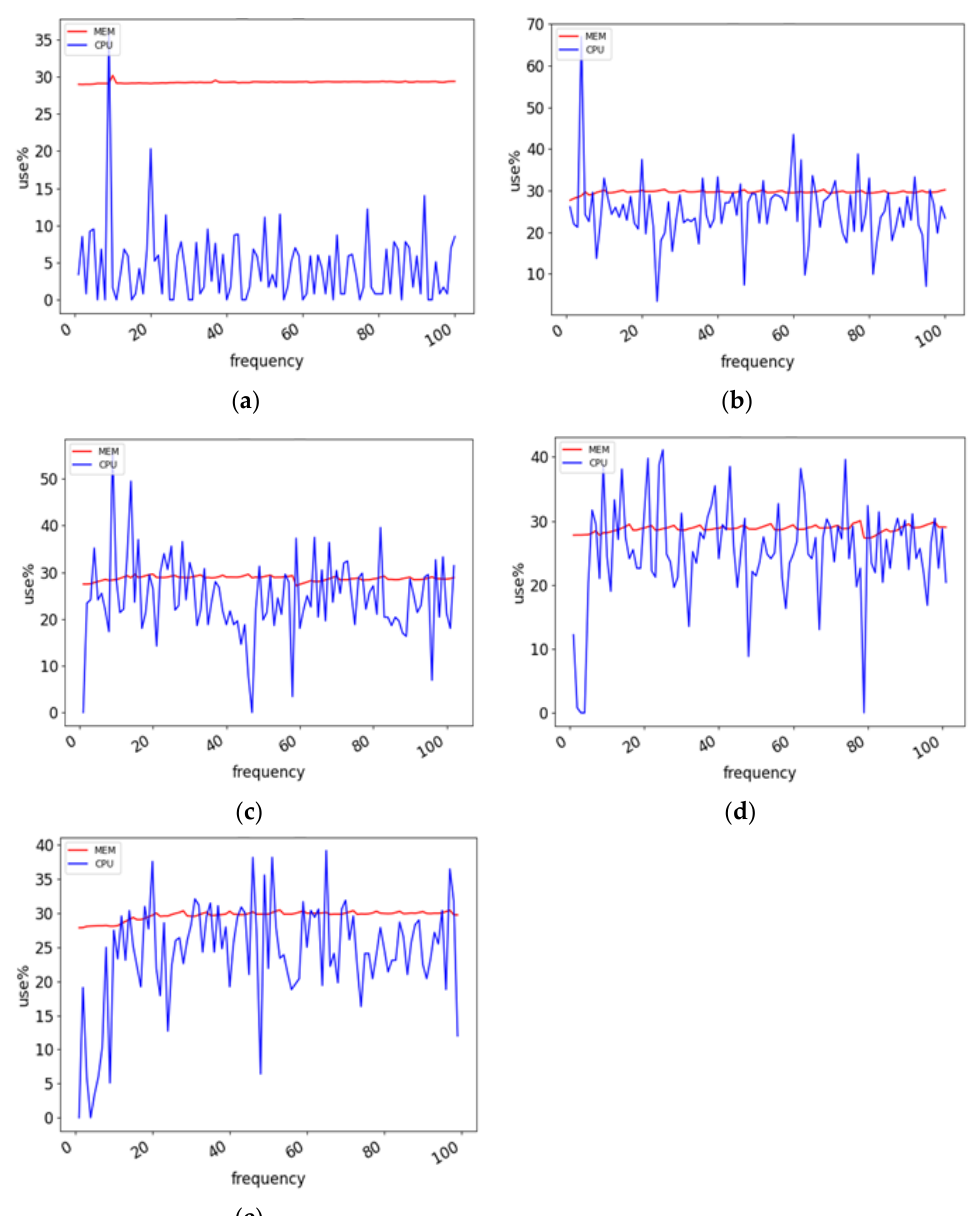
Figure 17. CPU and memory usages ( a ) normal transmission; ( b ) SYN flood attack; ( c ) UDP flood attack; ( d ) ICMP flood attack; ( e ) MIX flood attack. Table 4. Average speed under the normal transmission, SYN flood attack, UDP flood attack, ICMP flood attack, and MIX flood attack.